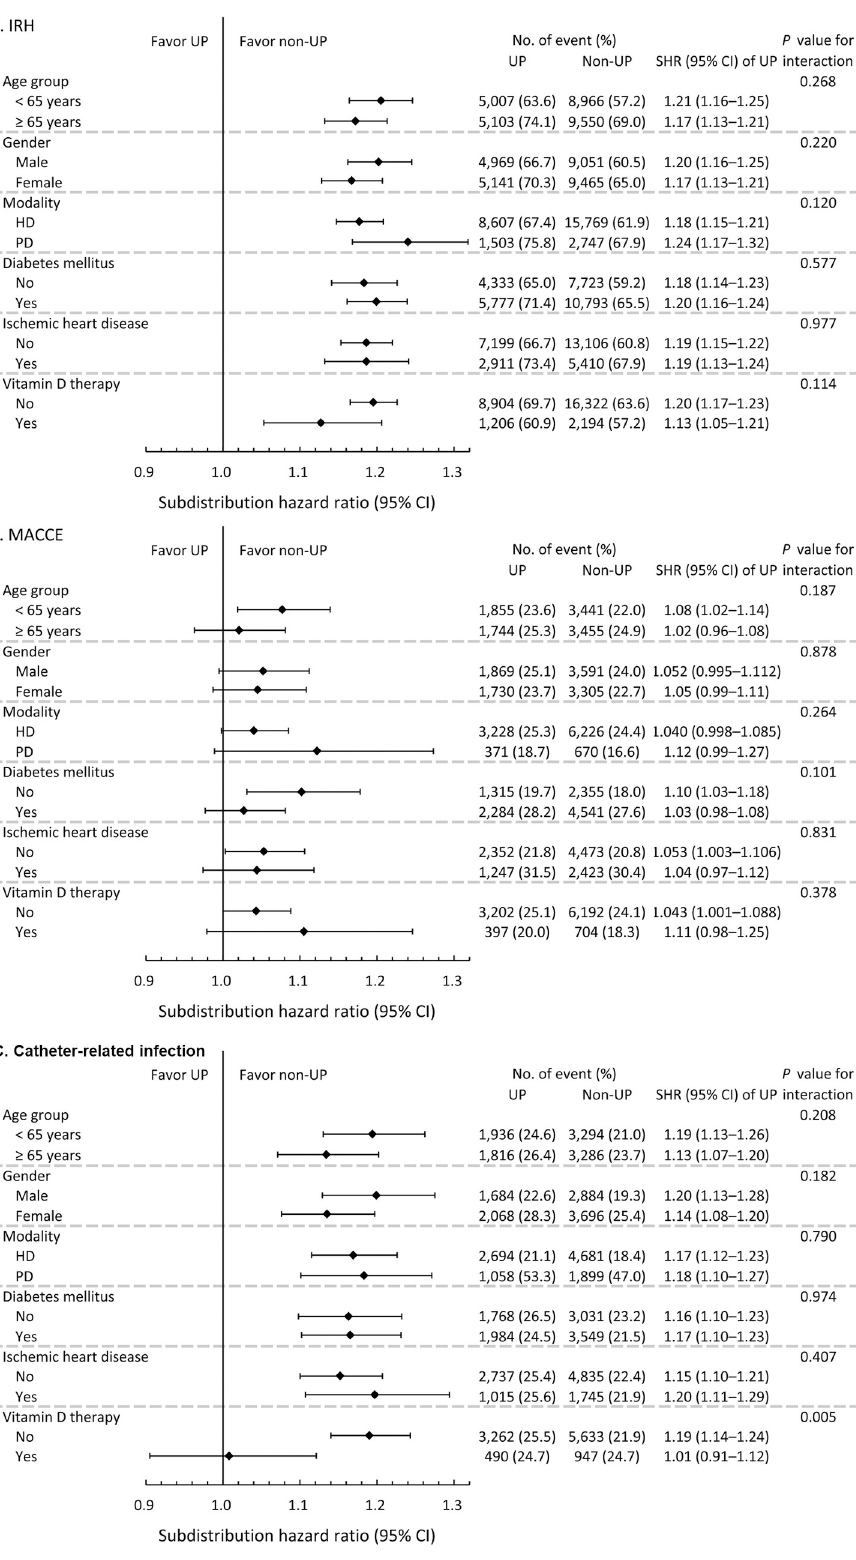
Fig 3. Prespecified subgroup analysis of outcomes, including infection-related hospitalization (A), major adverse cardiac and cerebrovascular event (B) and catheter-related infection (C). https://doi.org/10.1371/journal.pone.0241088.g003 PLOS ONE | https://doi.org/10.1371/journal.pone.0241088 October 26,